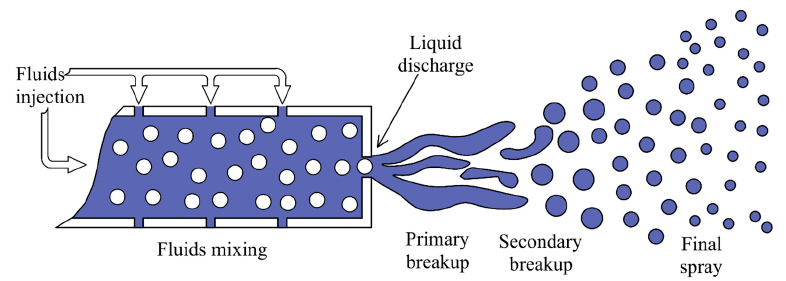
Figure 1. Schematic presentation of atomization; reproduced from